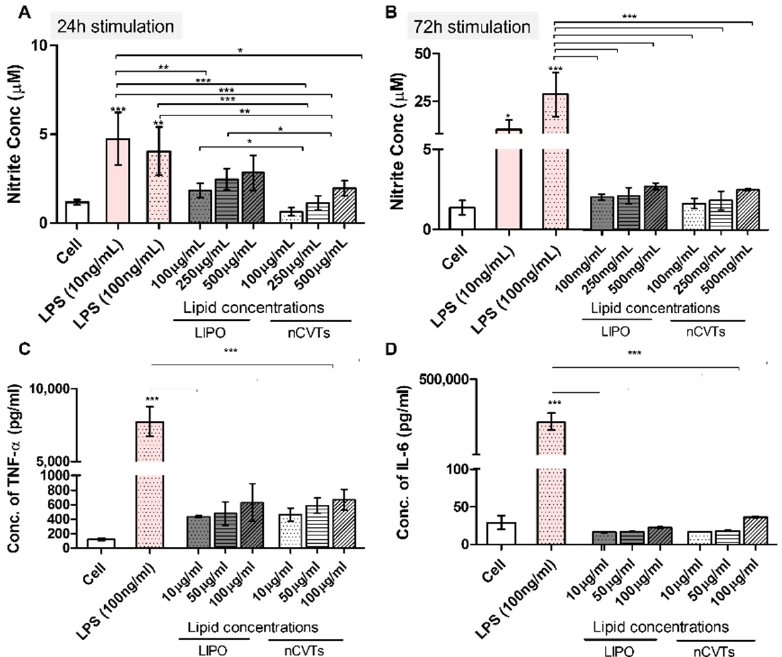
Figure 2. Immunological profile of nCVTs and liposomes (LIPOs). NO production upon treatment of nCVTs and liposomes after ( A ) 24 h of stimulation and ( B ) 72 h of stimulation. Production of pro-inflammatory cytokines: ( C ) TNF- α and ( D ) IL-6 by RAW264.7 cells after 72 h of treatment of respective formulations; ( n = 3/groups) * p < 0.05, ** p < 0.01, and *** p < 0.001.